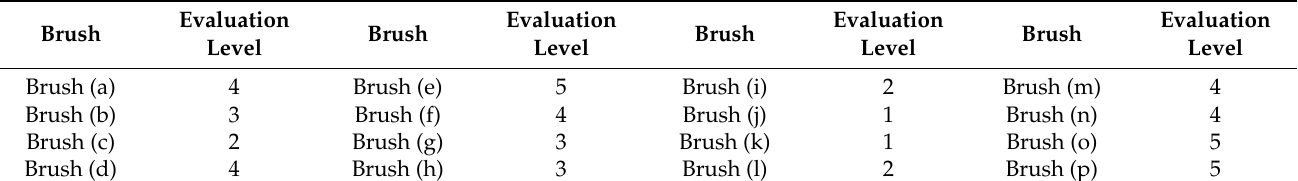
Table 8. Subjective evaluation of brushing results for sixteen horizontal micro-manipulators.